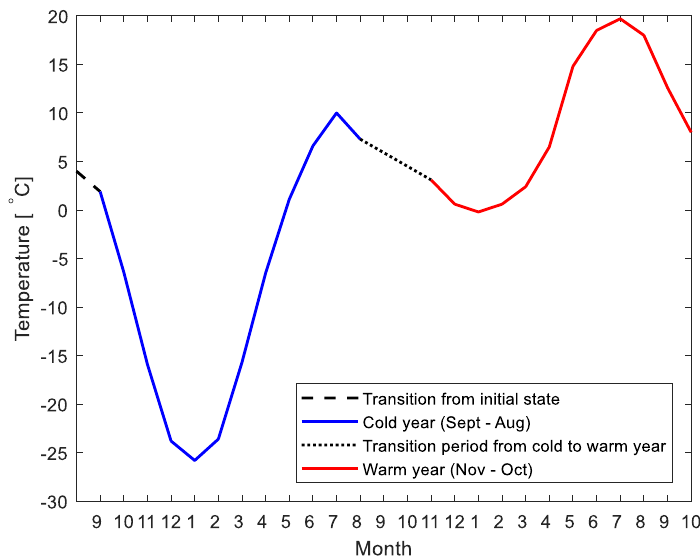
Figure 4. Illustration of the combined temperature profile for an extreme cold year followed by an extreme warm year. From [1].